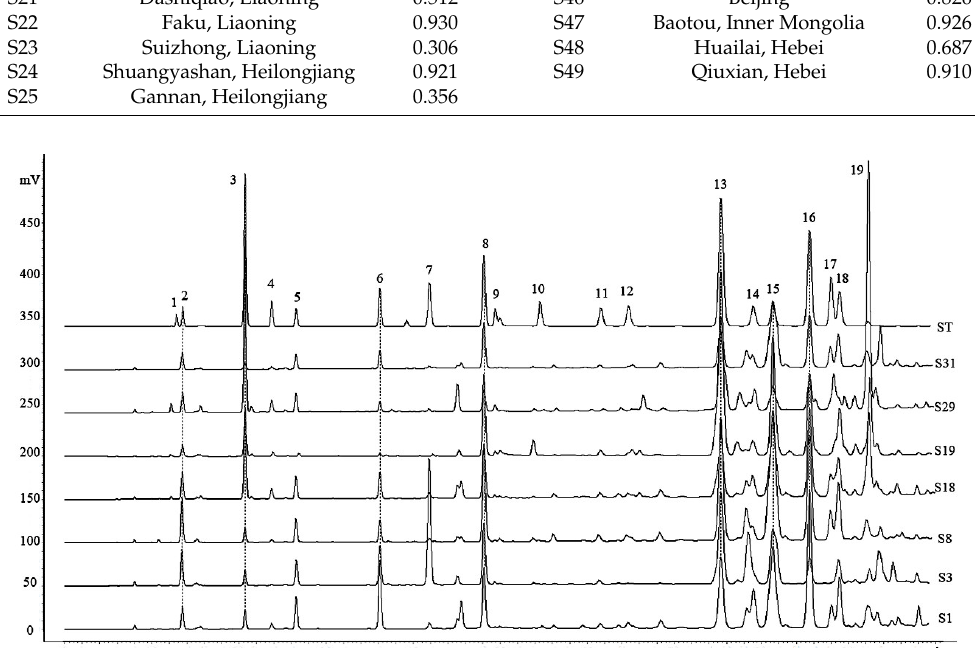
Figure 1. High-performance liquid chromatography (HPLC) chromatograms of the standard solution (ST) and Chinese propolis (S1,S3, S8, S18, S19, S29, S31): 1. Vanillic; 2. Caffeic acid; 3. p -Coumaric acid; 4. Ferulic acid; 5. Isoferulic acid; 6. 3,4-Dimethoxycinnamic acid; 7. Cinnamic acid; 8. Pinobanksin; 9. Naringenin; 10. Quercetin; 11. Kaempferol; 12. Apigenin; 13. Pinocembrin; 14. Benzyl caffeate; 15. 3- O -acetylpinobanksin; 16. Chrysin; 17. Caffeic acid phenethyl ester (CAPE); 18. Galangin; and 19. Benzyl p -coumarate.